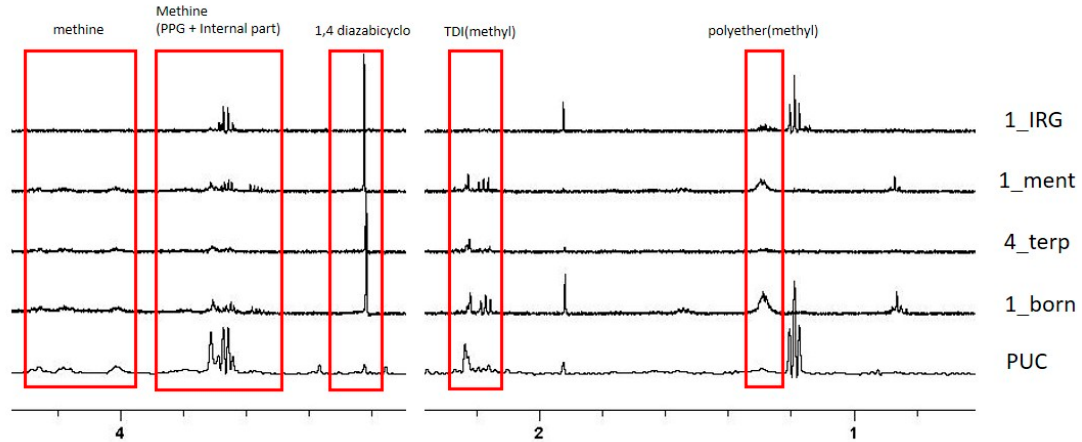
Figure 4. Selected regions of 1D 1 H NMR spectra of 1_irgasan, 1_ menthol, 4_terpineol, and 1_borneol and PUC are shown. Assignment of selected peaks is reported.